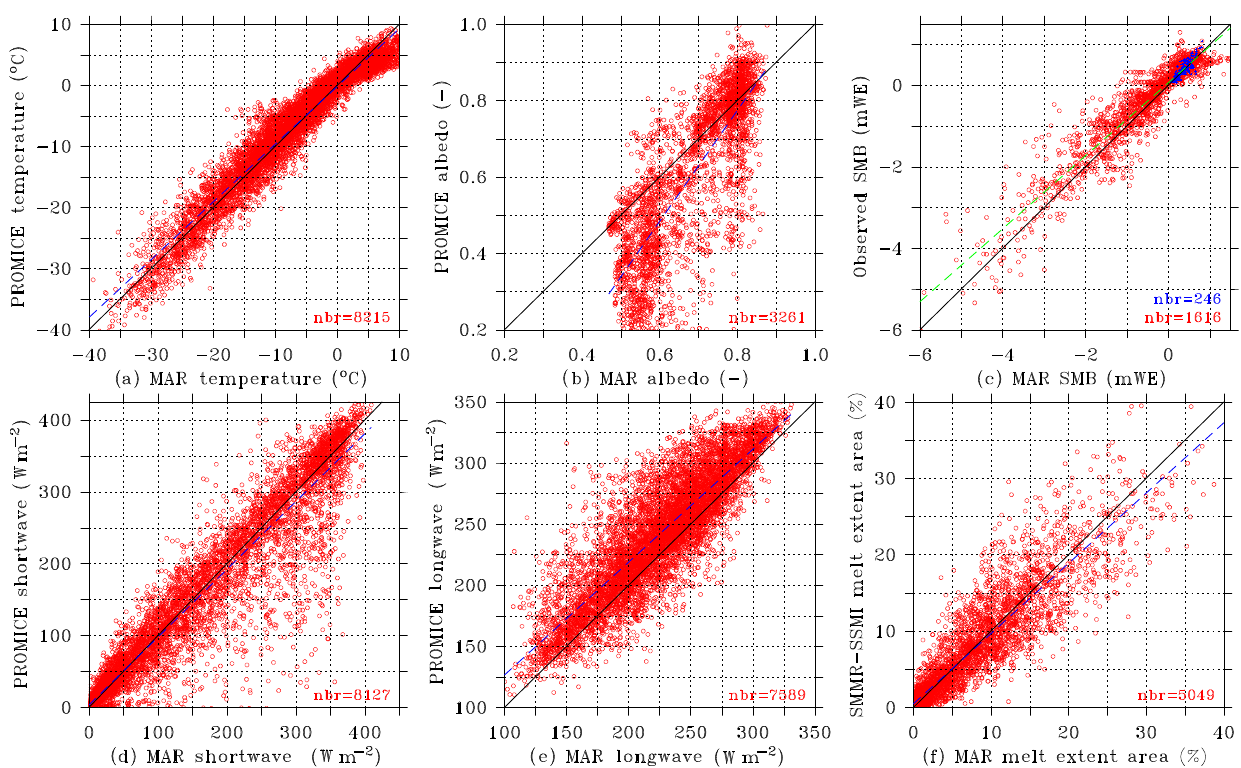
Figure 5. (a) Scatter plot of the MAR ERA − Interim daily near-surface temperature vs. near-surface daily temperature recorded by 12 AWSs from the PROMICE network over 2008–2010. The number of observations used here is listed in red and units are ◦ C. (b) Same as (a) but for the surface albedo. (c) Scatter plot of the MAR ERA − Interim SMB (in mw.e.) with respect to ice core measurements in the accumulation area (in blue) and SMB measurements (in red) from the MACHGUTH16 dataset over 1958–2010. We refer to the text for more details on how this comparison is performed. (d) Same as (a) for the shortwave downward radiative flux (in Wm − 2 ). (e) Same as (d) for the longwave downward radiative flux. (f) Daily melt extent (in % of the ice sheet area) simulated by MAR ERA − Interim over the 1979–2010 summers (May–September) vs. the satellite-derived one. More information about the thresholds used for retrieving the melt extent is given in the